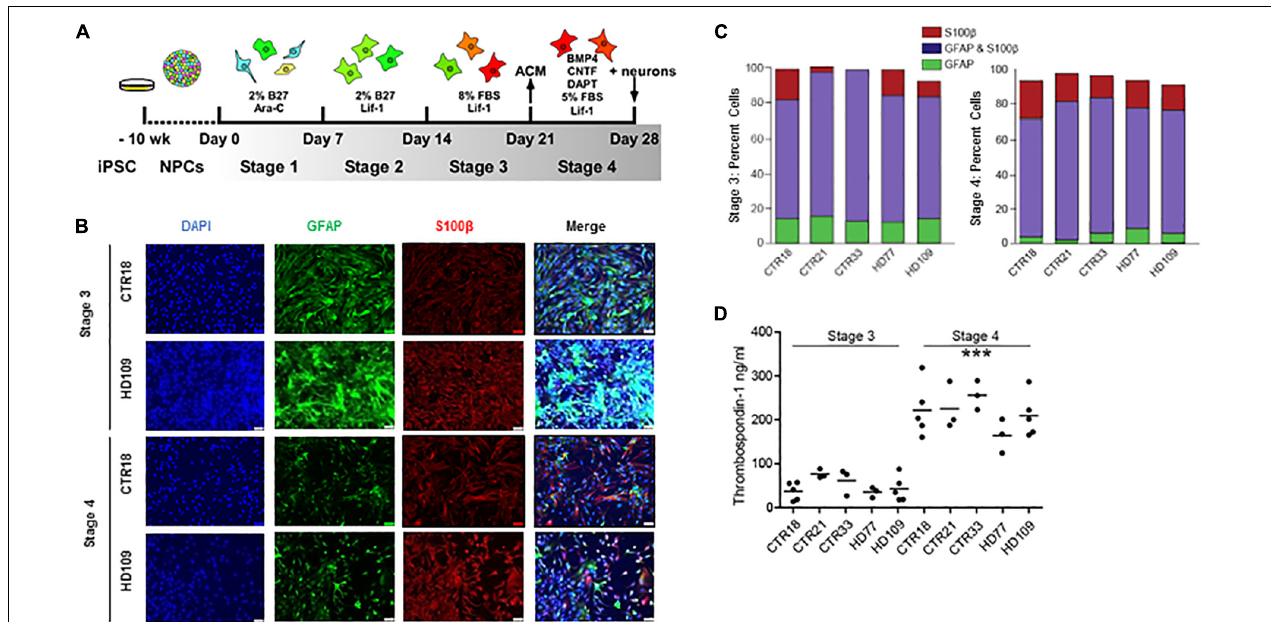
FIGURE 1 | Huntington’s disease and control iPSCs are equally capable of generating mature astrocytes. (A) Schematic of astrocyte differentiation from iPSC-derived neurospheres. (B) Immunocytochemistry of Stages 3 and 4 astrocytes stained for GFAP and S100 β . (C) Stage 3 (left) and Stage 4 (right) display astrocyte markers GFAP and/or S100 β in equal percentages between HD and controls. ( n = at least three independent experiments per line and more than 1,900 DAPI-positive cells). (D) Stage 4 astrocytes derived from either HD or control iPSCs release more TSP1 than Stage 3 astrocytes in all lines tested, indicative of increased maturity ( ∗∗∗ p < 0.001; n = 3–5 independent